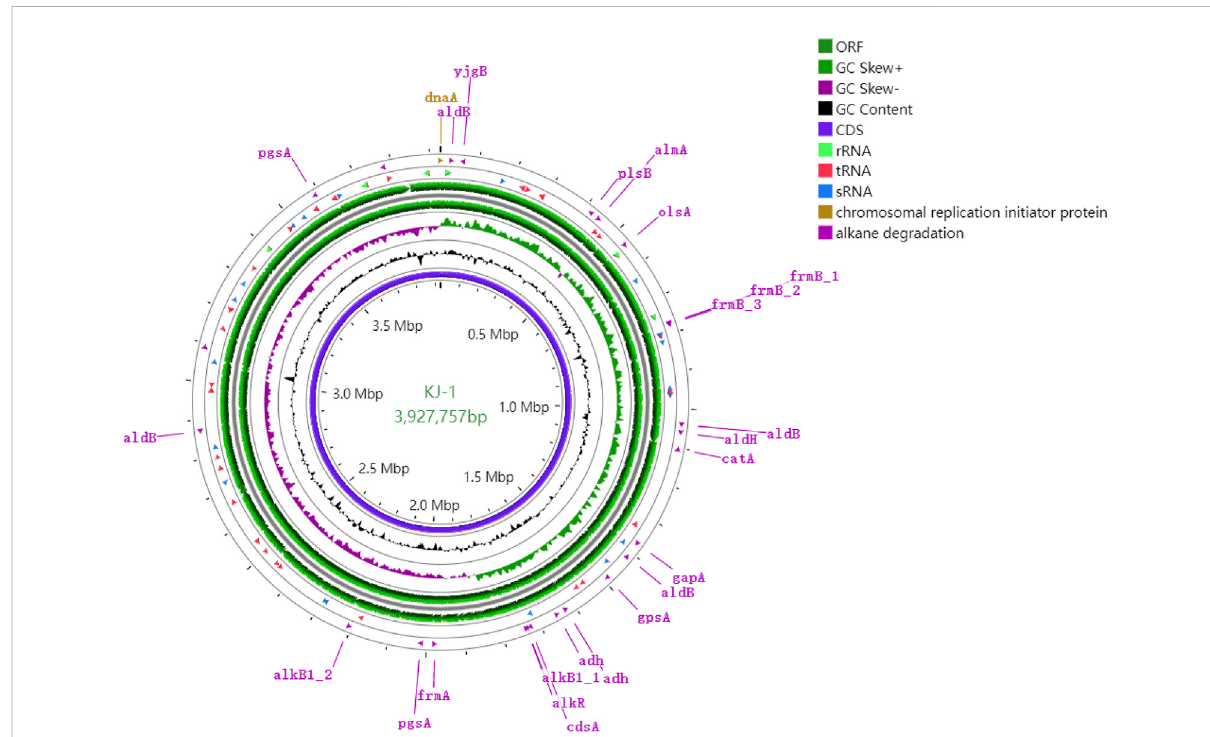
FIGURE 5 Circular representation of genome and features of the KJ-1. The contents of the featured rings (starting with the outermost ring to the center) are as follows. Ring 1: genes involved in alkane degradation, combined forward and reverse strand; Ring 2: RNA (including tRNA, sRNA and rRNA) combined forward and reverse strands; Ring 3 and 4: CDS in forward and reverse strands; Ring 5: GC skew plot, values above average is depicted in green and below average in purple; Ring 6: plot of GC content; Ring 7: Combined ORFs in forward and reverse strands; Ring 8: sequence ruler. The fi gure was produced using Proksee